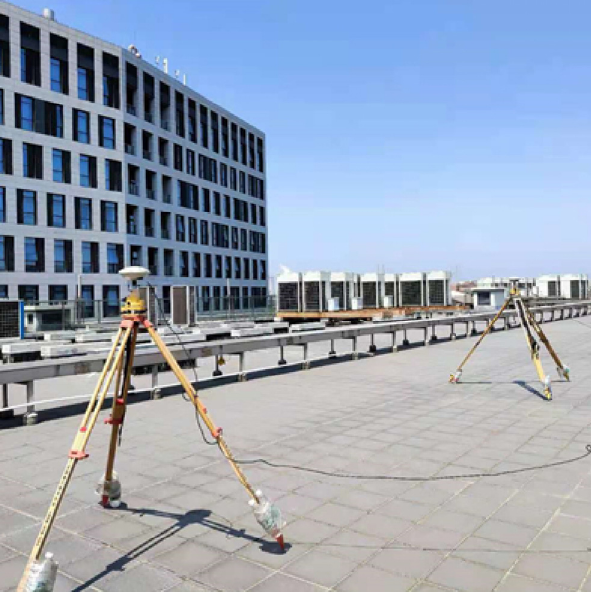
Figure 1. Photographs of the dual antennas on the roof of a building.